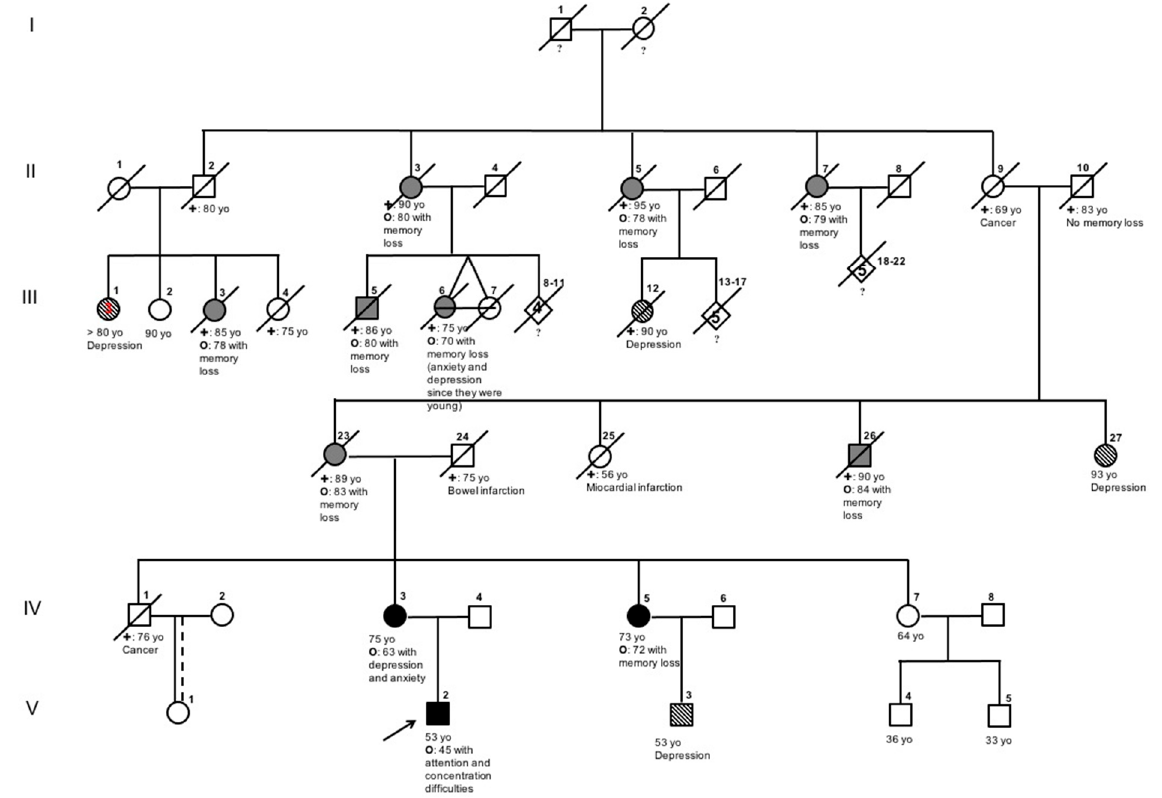
Figure 2. Family pedigree. Symbols: roman numbers to the left of the pedigrees denote generations. The arrow indicates the proband. Circles indicate females and squares indicate males. Fully black symbols indicate the examined affected individuals. Fully gray symbols denote the individuals reported as affected by the informants. Striped symbols denote personal history of depression.